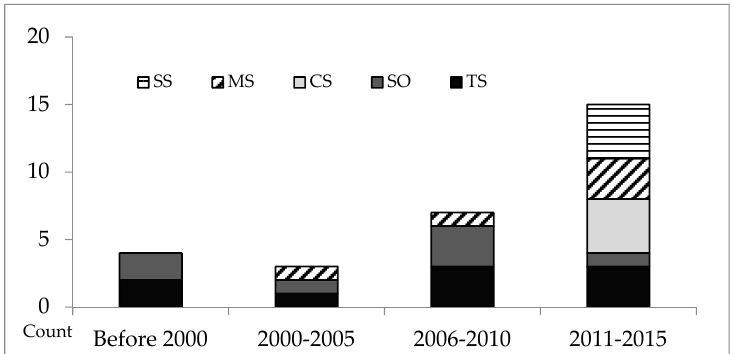
Figure 4. Trend of systems linked with land use systems via feedbacks in models. TS: transport system; SO: soil system; MS: market system; CS: climate system; and SS: social system.